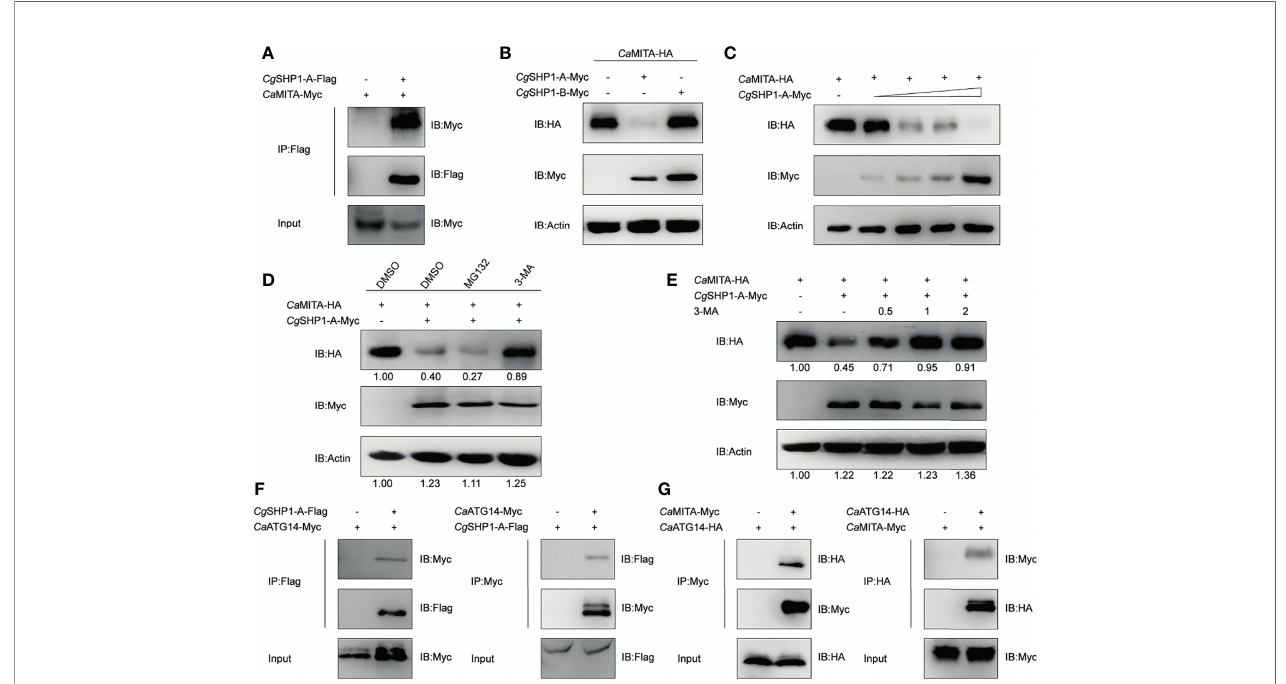
FIGURE 7 | Cg SHP1-A interacts with and degrades Ca MITA byautophagypathway. (A) Co-IP analysisbetween Cg SHP1-A and Ca MITA. (B – D) Cg SHP1-A degrades Ca MITA ina dose-dependent manner by autophagypathway. 1.5 m g Ca MITA-HA co-transfected with 1.5 µg Cg SHP1s-Myc (B) and various concentration of Cg SHP1-A- Myc (0.5 m g, or 1 m g, or1.5 m g or2 m g, empty vectorwas used to makeup the rest) (C) in EPC cells. At 18 h post-transfection, the cells were treated with DMSO, MG132 and3-MAfor 6 h (D) . The celllysates were subjected to IB.Experiments wererepeatedfor at least three times with similar results . (E) Effects of3-MAon Cg SHP1-A mediateddestabilization of Ca MITA. Transfection with the indicatedexpression vectors (2 m g/well)and treated with DMSO or3-MA(0.5, 1, or 2 mM) for 6 h at 18 h post- transfection, the WCLswere analyzed by IB. (F, G) Co-IP of Cg SHP1-A-Flag with Ca ATG14-Myc (F) or Ca MITA-Myc with Ca ATG14-HA (G) inHEK 293T